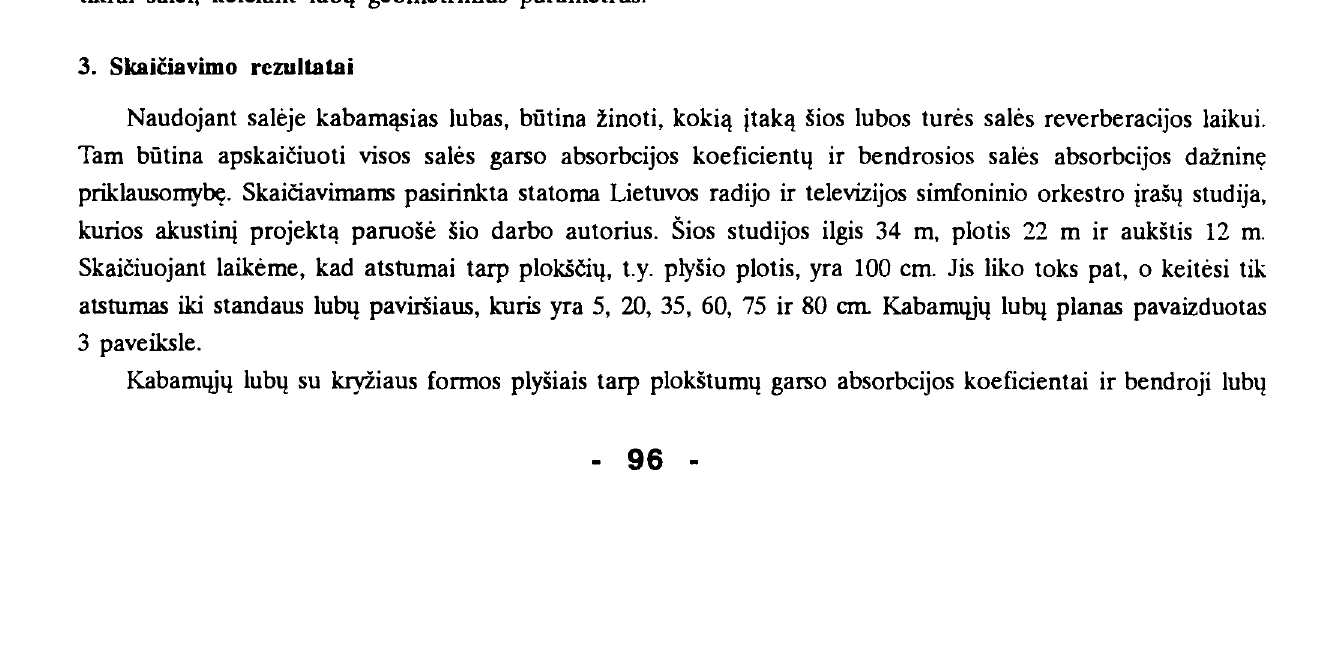
Bendras impedansas, iSdestytas skyliq plokStumoje bus